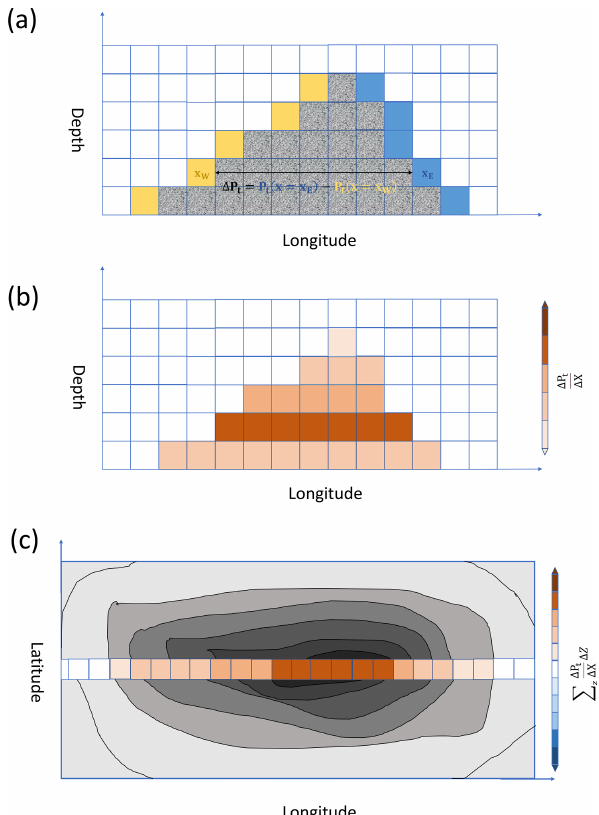
Figure B1. Assume that there is a submerged seamount. Panel (a) shows a zonal slice of a seamount, where white cells indicate seawater and grey cells indicate landmasses. Grids in yellow are the grids adjacent to the western face of the seamount, and grids in blue are the grids adjacent to the eastern face of the seamount. In panel (b) , the pressure difference is divided by the width of the seamount to give the (cid:49)P t /(cid:49)X , which is assigned to every grid of the seamount in each vertical level. Panel (c) shows the vertically integrated topographic form stress field across the seamount. This figure is adapted from Masich et al.